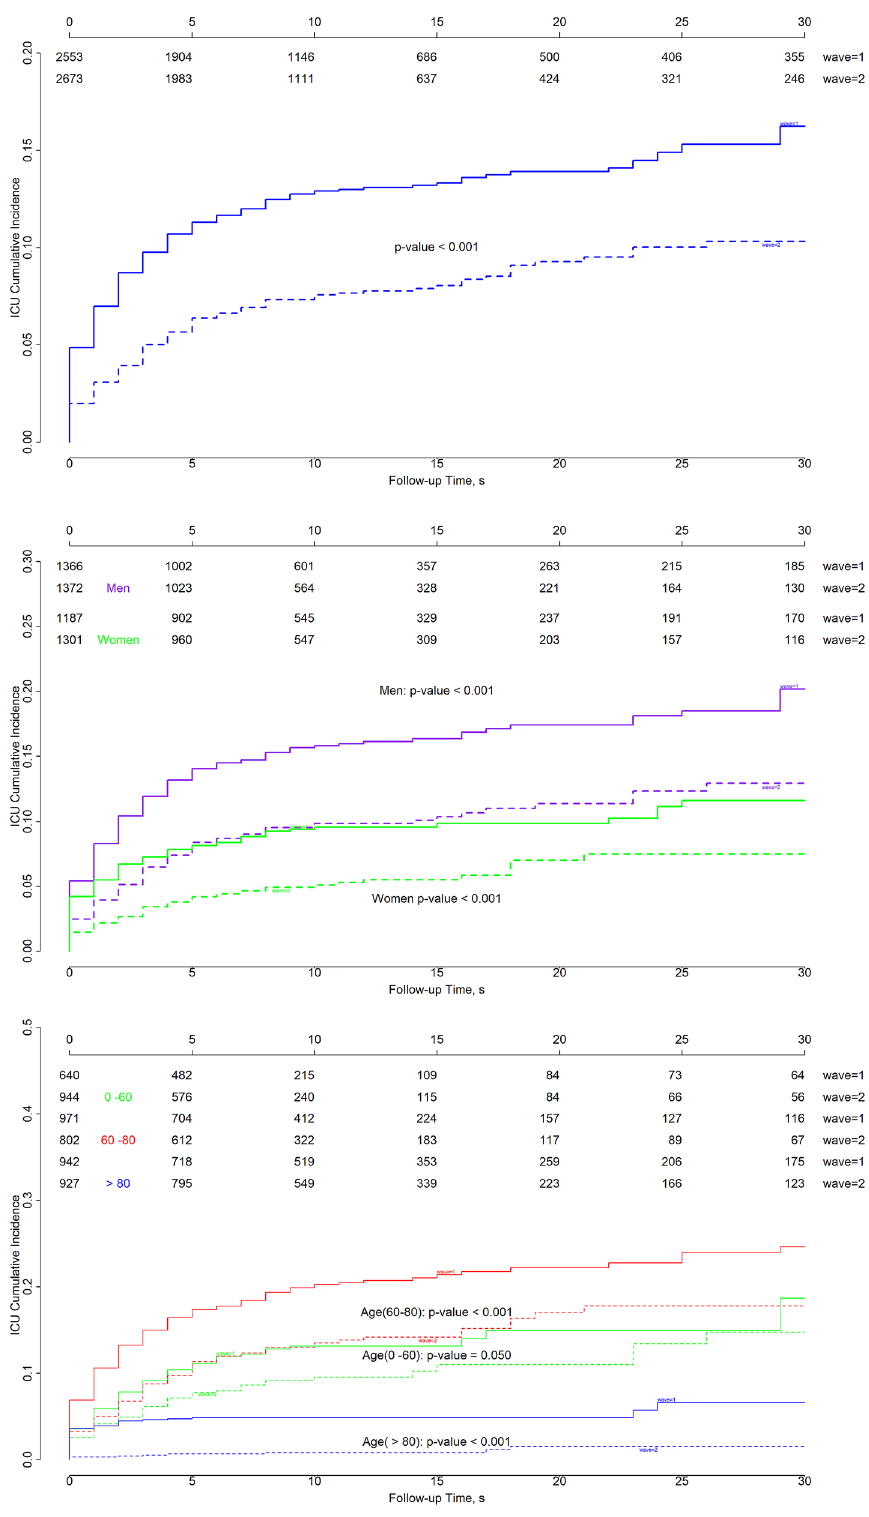
Figure 5. Cumulative incidence of ICU admissions for all patients ( top), patients stratified by sex (middle ), and patients stratified by age ( bottom) in Aragon, Spain, February-September 2020. By sex: purple indicates men, green indicates women. By age: green indicates 0–60 years, red 60–80 years, and blue > 80 years. Solid lines : first wave; dashed lines : second wave. The p-values corresponds to the Gray test to compare survival curves between waves for groups stratified by sex or